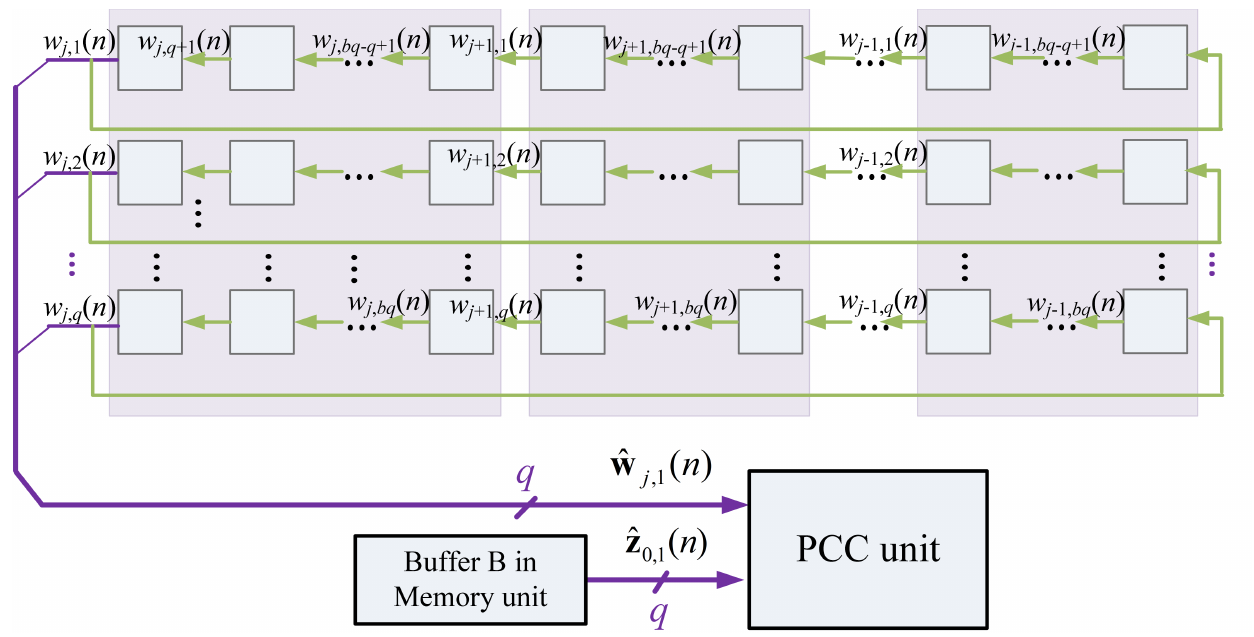
Figure 12. The Buffer C operation for the PCC